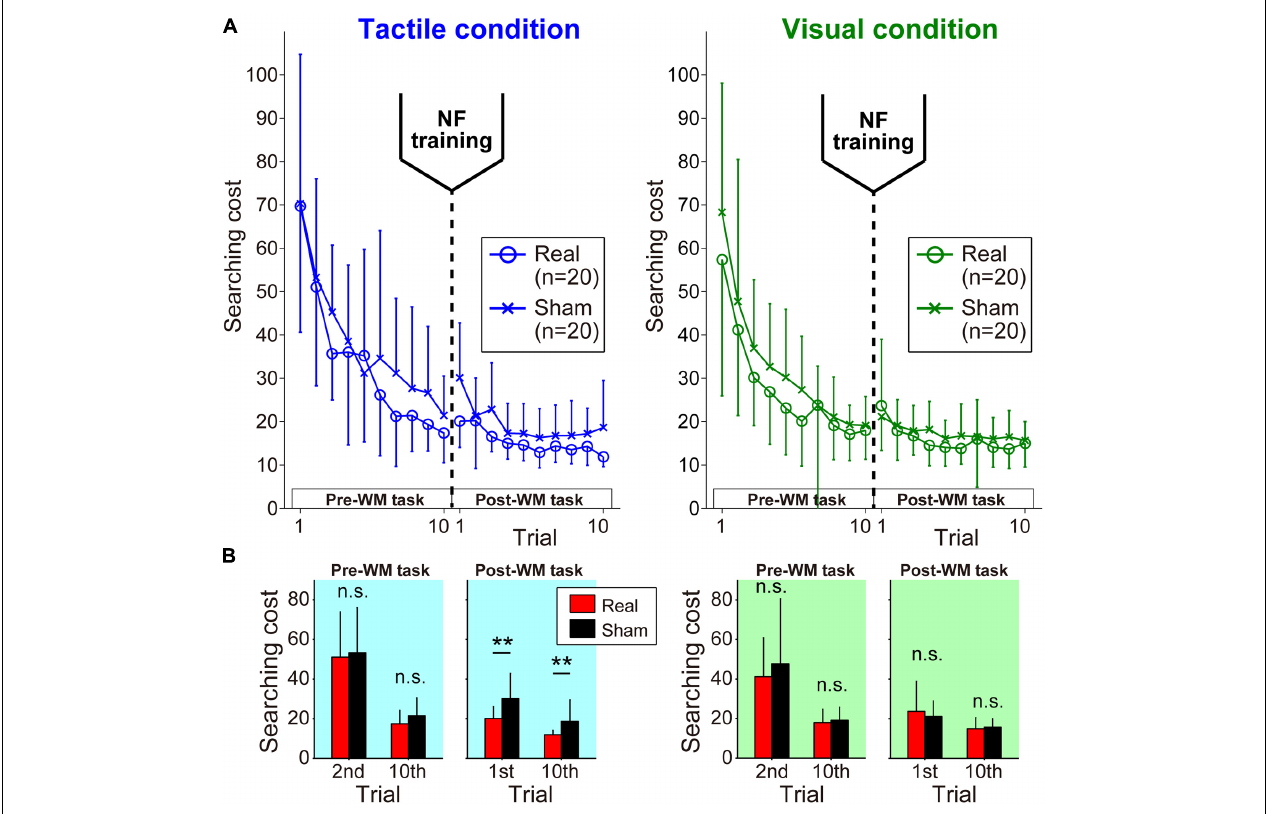
FIGURE 3 | Learning curves during pre- and post-WM tasks. (A) In each task phase, the participants successfully reduced the searching cost. (B) The Real group showed significantly better performance in the Post-WM task only under the tactile condition. Error bars denote the standard deviation. ** p < 0.01.